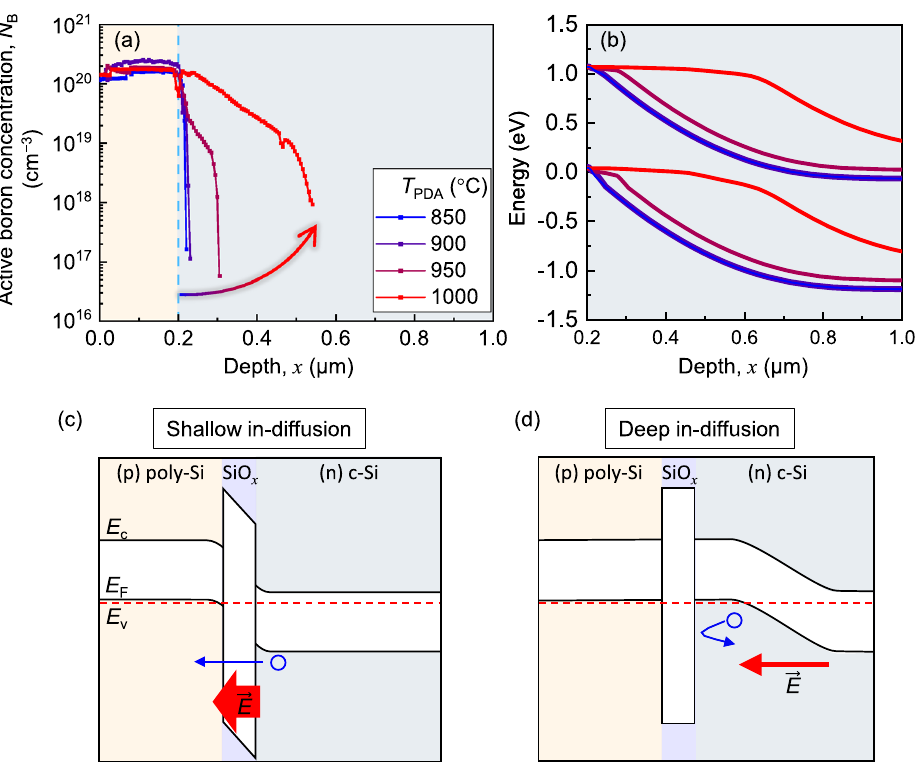
Figure 5. ( a ) ECV profiles of the active boron concentration annealed at 850 °C, 900 °C, 950 °C, and 1000 °C for the samples with 1.5-nm-thick SiO x layers and ( b ) simulated band diagrams based on the PC1D simulation. Schematic of the band structures corresponding to ( c ) the shallow in-diffusion and ( d ) deep in-diffusion of the boron